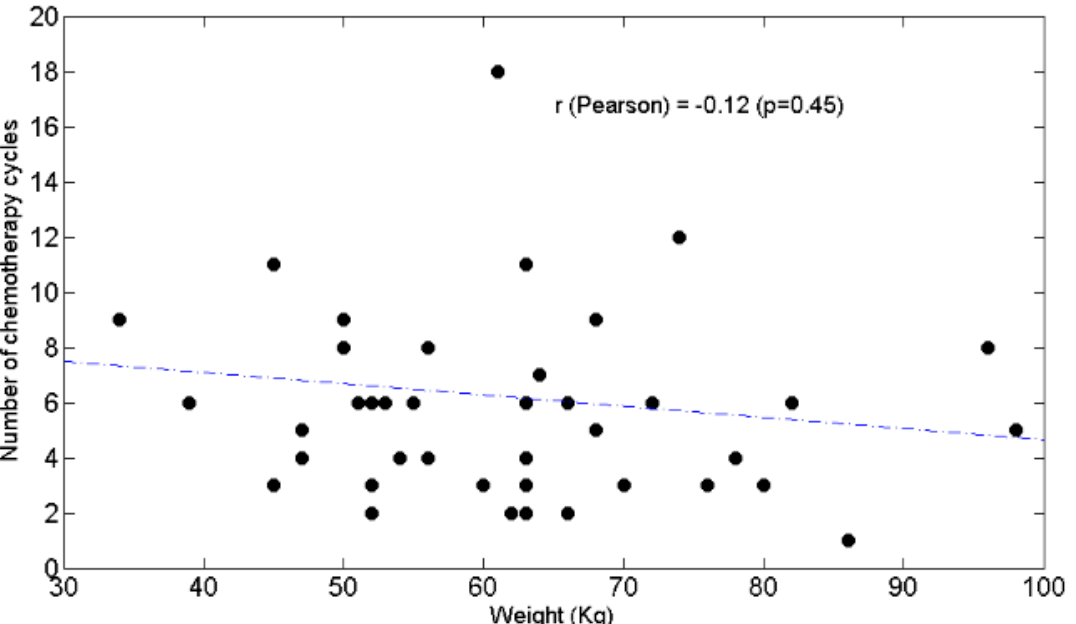
Figure 4. Scatter plot of the neutrophils/lymphocytes ratio (y axis) as a function of weight (x axis). The value of Pearson’s correlation coefficient and corresponding p value are also reported. Figure 5. The number of chemotherapy cycles is not significantly linked to body weight (Kg).